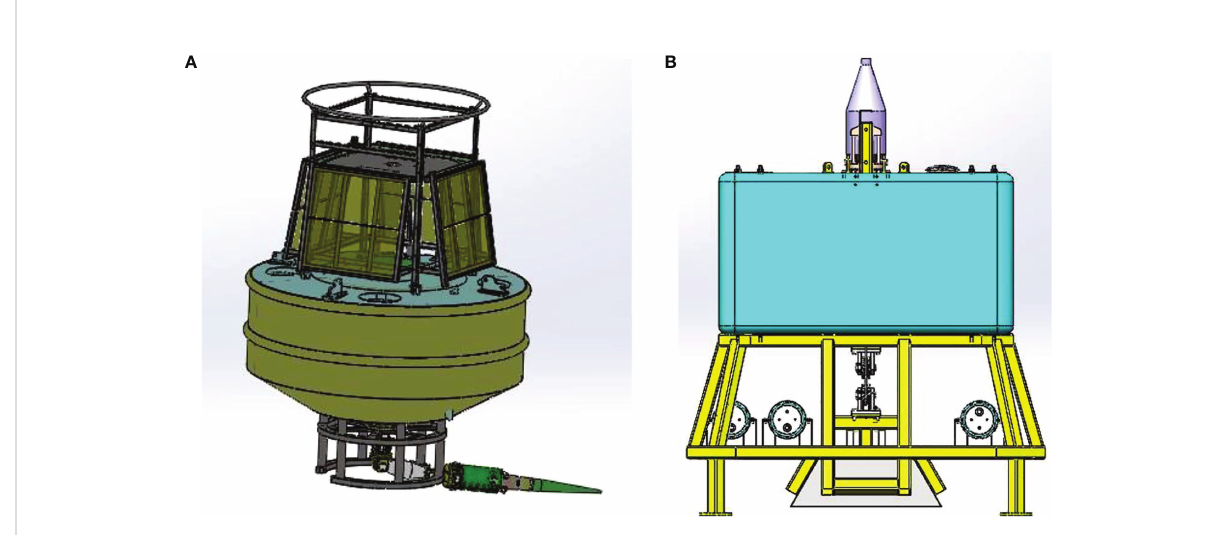
FIGURE 3 Mechanical design of buoy and benthic observation node. (A) Buoy (B) Benthic observation